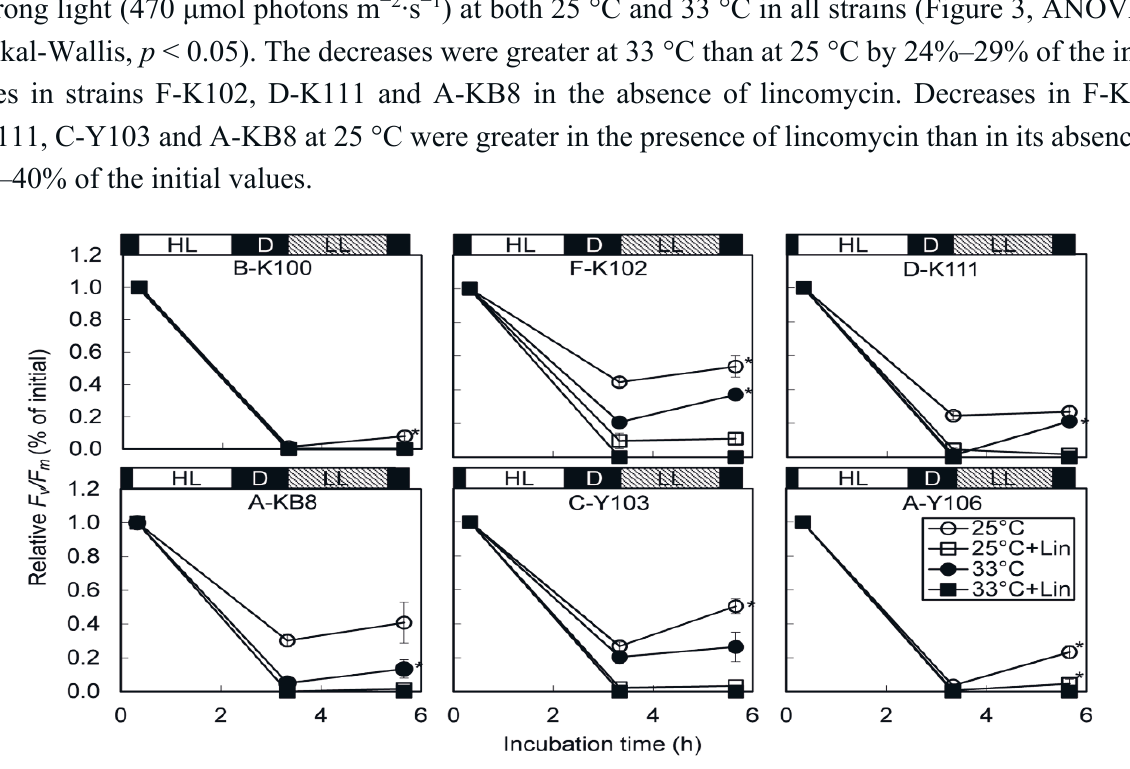
Figure 3. Photodamage and photorepair in six strains of Symbiodinium cells at 25 and 33 °C. Photochemical efficiencies ( F v /F m ) were measured before and after 2-h of exposure to strong light (HL, 470 μ mol photons m − 2 ·s − 1 ), and after a 2-h recovery period under dim light (LL, 20 μ mol photons m − 2 ·s − 1 ) at both temperatures. Cultured Symbiodinium cells were incubated in the presence (squares) or absence (circles) of 200 μ g mL − 1 lincomycin at 25 (open symbols) or 33 °C (closed symbols), *: significant recovery after the strong light treatment (Tukey’s HSD test, p < 0.05). Means ± SD ( n =